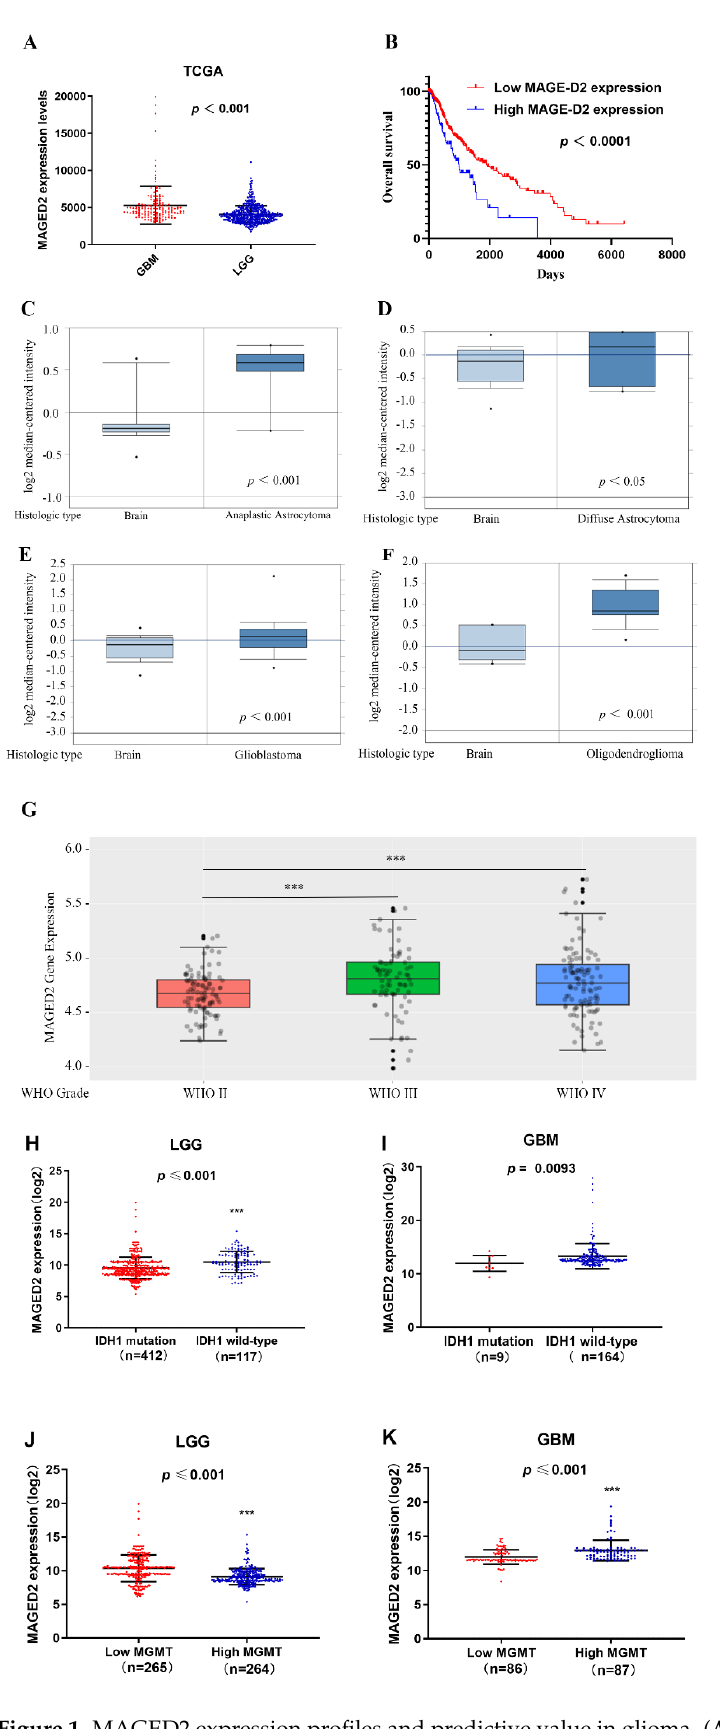
Figure 1. MAGED2 expression profiles and predictive value in glioma. ( A ) According to the